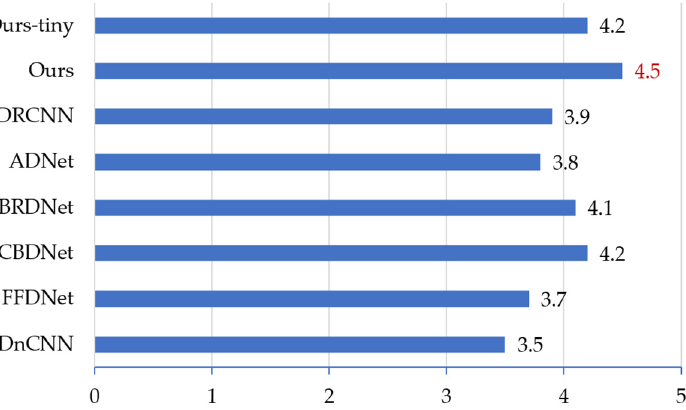
Figure 9. Mean opinion scores (MOS) comparison of denoising results on the nuclear radiation dataset.